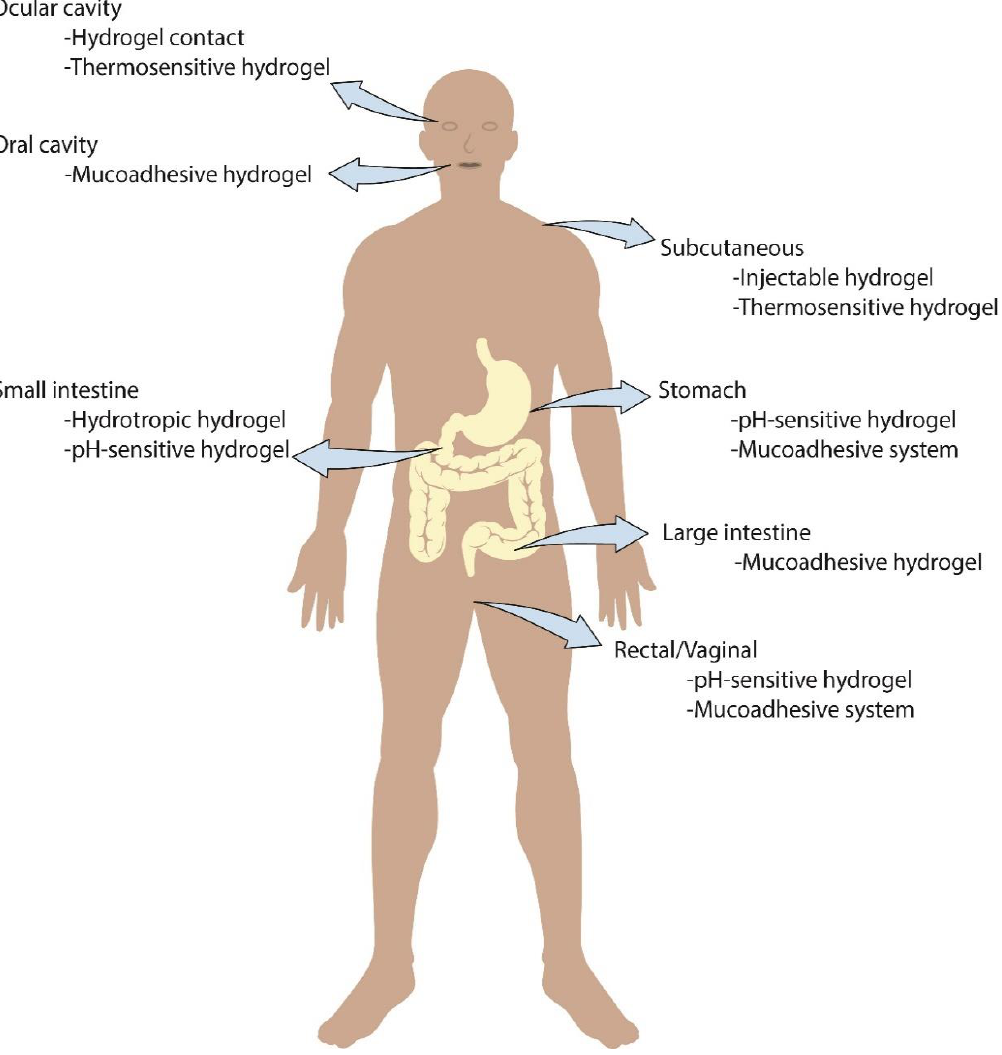
Figure 2. Applications of hydrogels in different human body parts.